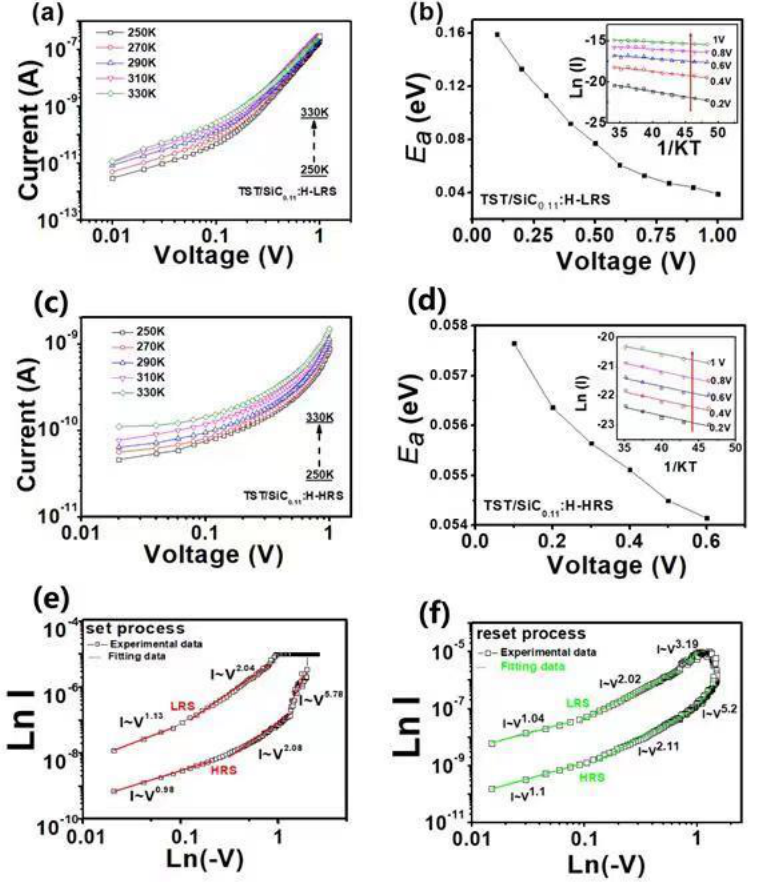
Figure 5. ( a – c ) Temperature-dependent current of the ATSS device in the HRS and the LRS at temperatures from 250 K to 330 K; ( b – d ) The activation energy of the ATSS device in the HRS and LRS, which is decreased with the voltage increasing. The inset shows an Arrhenius plot of the temperature-dependent current of the HRS and the LRS. The current intensity is enhanced with the voltage increasing as marked by the red arrows; ( e , f ) The experimental and theoretical fitting curves of the set and reset process of the Al/a-SiC 0.11 :H/p + Si device. To enable the Al/TiSbTe/a-SiC 0.11 :H/P + -Si device to be used as an artificial synapse for integration into a brain-inspired chip, we studied the long-term memory and the short-term memory characteristics of the Al/TiSbTe/a-SiC 0.11 :H/P + -Si artificial synapse. As shown in Figure 6a, the structure of the biological synapse was similar to that of the prepared Al/TiSbTe/a-SiC 0.11 :H/P + -Si device. The pre-synaptic and post-synaptic neurons could be regarded as the top electrode and the bottom electrode, respectively. To make the Al/TiSbTe/a-SiC 0.11 :H/P + -Si device emulate the function of the biosynapse, the multi- level resistive switching characteristics of the Al/TiSbTe/SiC 0.11 :H/P + -Si device were measured by controlling the reset stop voltages, as shown in Figure 6b. The current de- creased gradually with the increasing of negative voltage, which was similar to the tun- able synaptic weight. We studied the short-term characteristic of the TiSbTe/SiC 0.11 :H ar- tificial synapse, which was spike-duration-dependent plasticistic (SDDP). The synaptic weight of the TiSbTe/SiC 0.11 :H synapse was effectively amplified by prolonging the du-